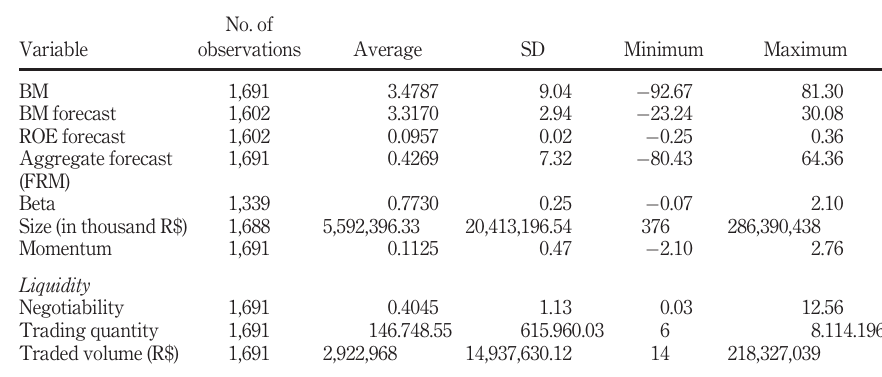
Table III. Descriptive statistics of the studied